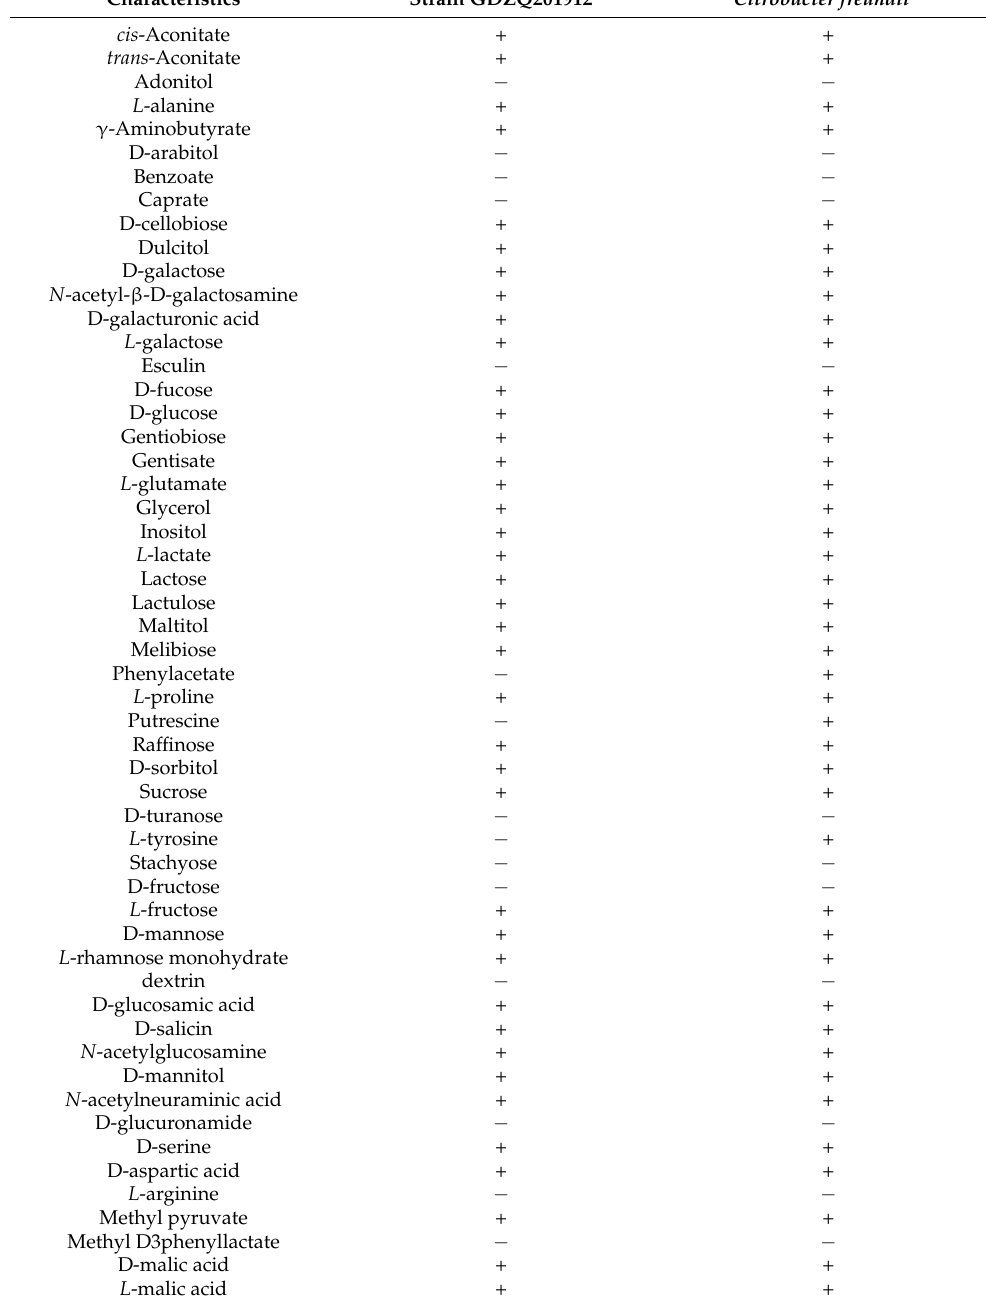
Table 4. Carbon source utilization reactions of strain